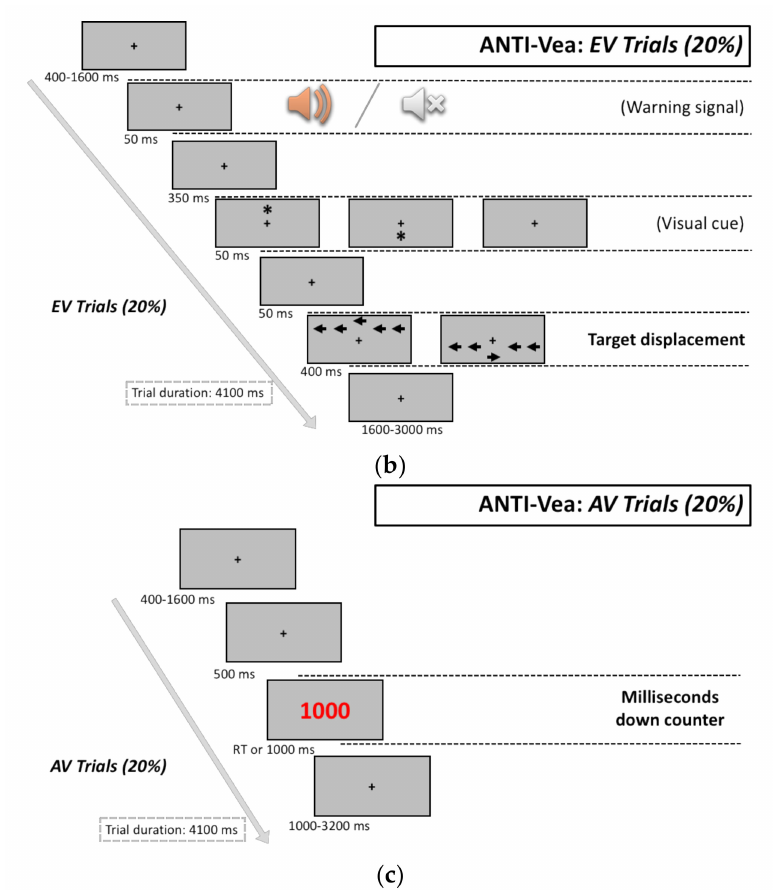
Figure 1. Experimental procedure and stimuli sequence in the Attentional Networks Test for Interactions and Vigilance—executive and arousal components (ANTI-vea) task: ANTI trials ( a ), executive vigilance (EV) trials ( b ), and arousal vigilance (AV) trials ( c